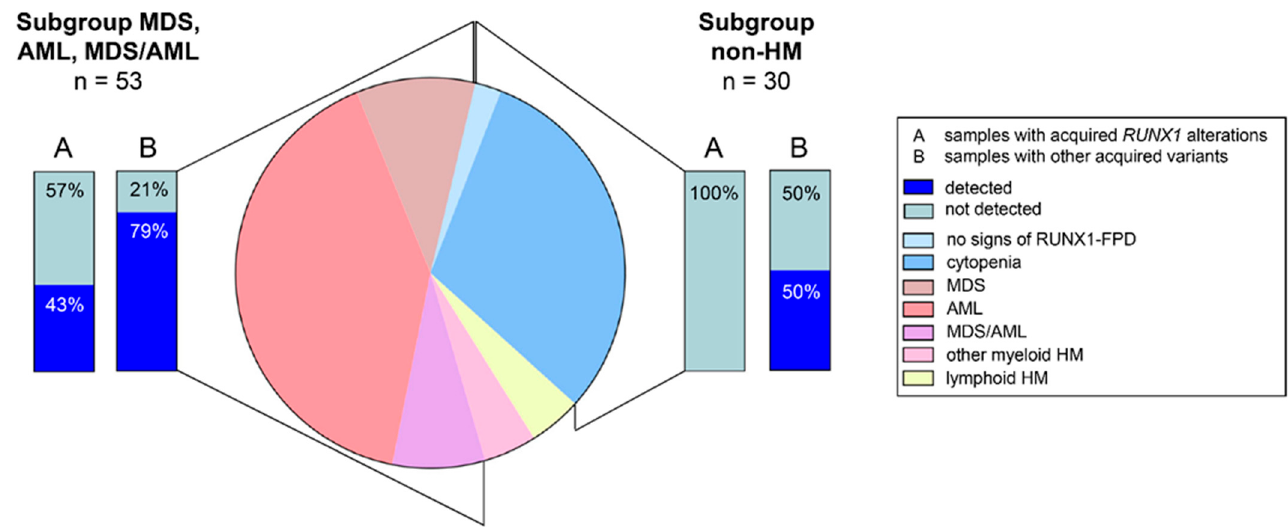
Figure 1. Phenotype and somatic variant status of our retrospective RUNX1-FPD cohort.